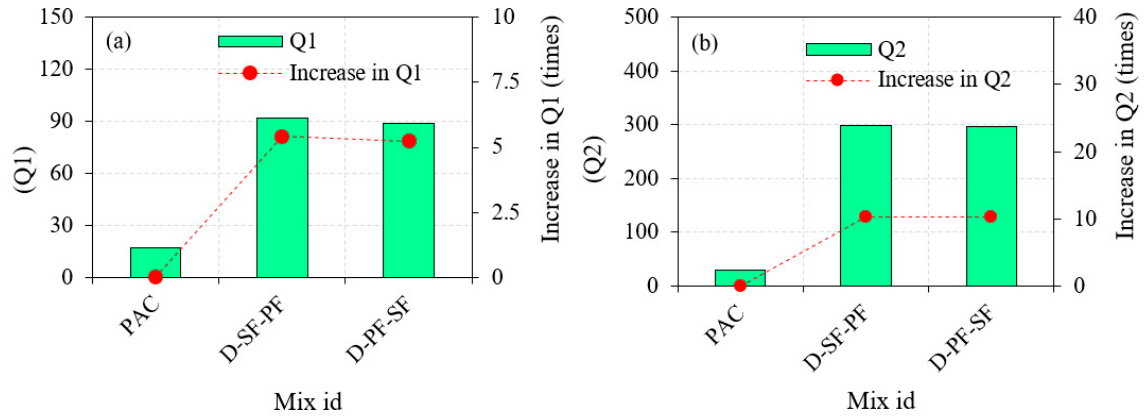
Figure 8. Impact strength of double-layered FLTSFC.